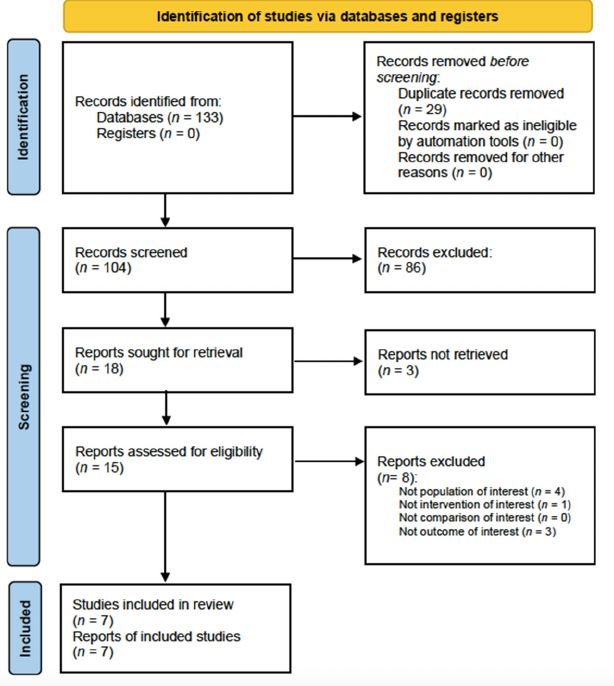
Figure 1. PRISMA 2020 Flow diagram.